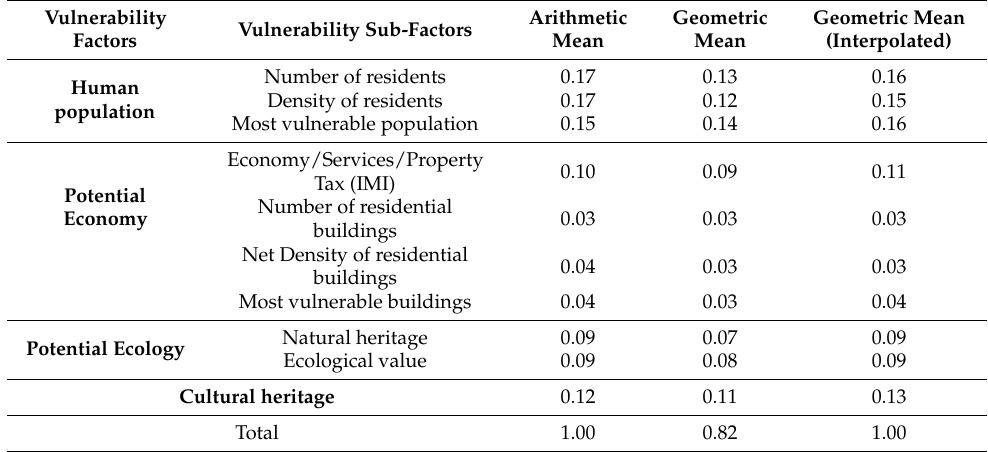
Table 18. Arithmetic mean, geometric mean, and interpolated geometric mean from the weighting of the vulnerability criteria, carried out by the consulted specialists.